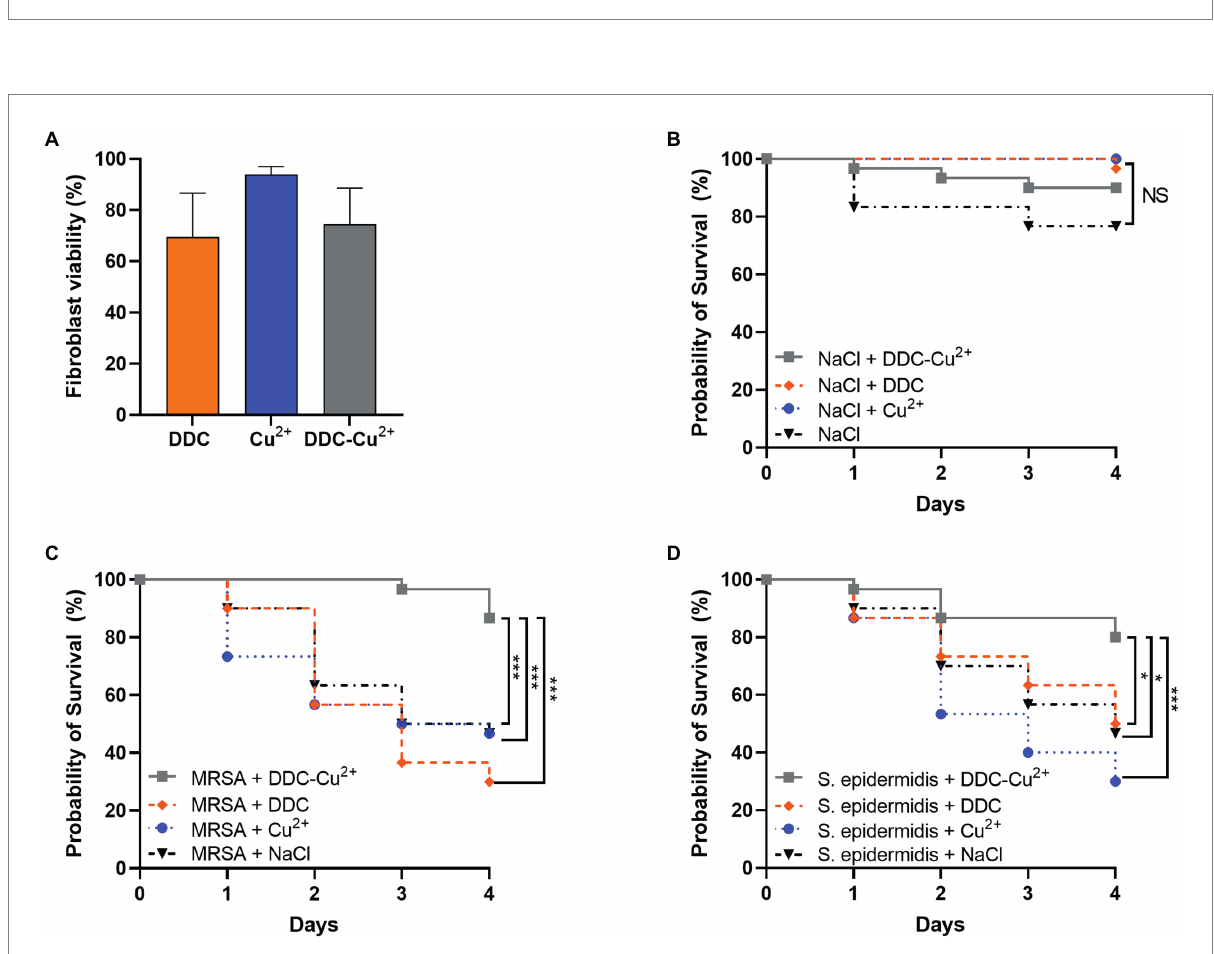
FIGURE 5 Effect of diethyldithiocarbamate [DDC; orange; 8 μ g/ml (A) , 6.4 mg/kg (B–D) ], Cu 2+ [blue; 32 μ g/ml (A) , 25.6 mg/kg (B–D) ] and DDC-Cu 2+ (grey) on (A) fibroblast viability ( n = 3), on (B) probability of Galleria mellonella survival (30/group; n = 120), on the probability of survival of Galleria mellonella infected with (C) MRSA Mu50 (30/group; n = 120), and (D) infected with S. epidermidis ATCC 35984 (30/group; n = 120; NS = not significant; * p < 0.05; *** p <